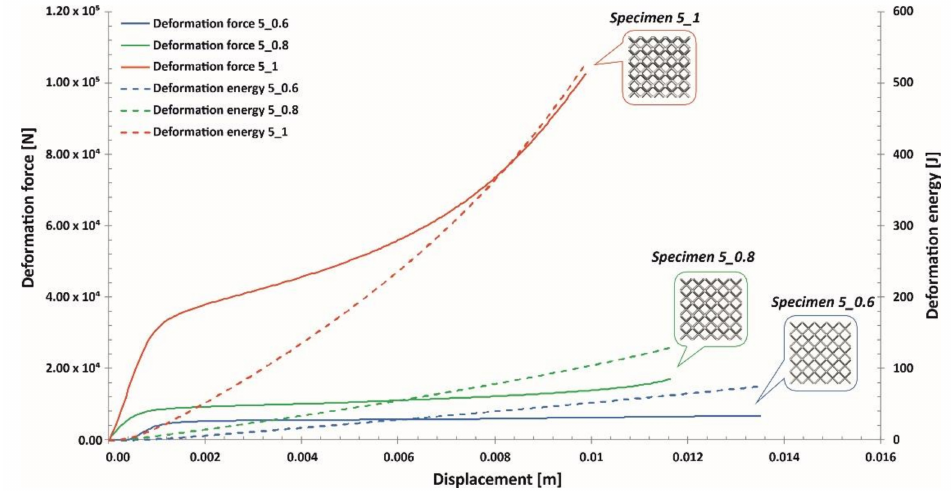
Figure 16. Deformation force and energy plots determined for lattice structures with an elementary unit cell equal to 5